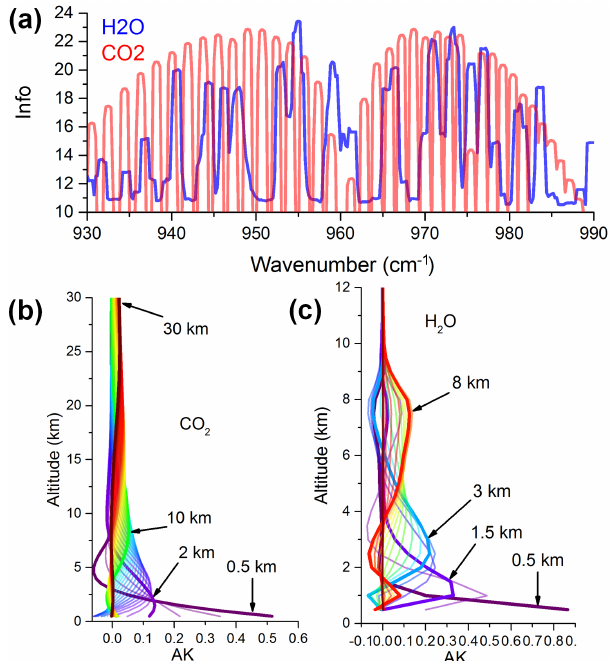
Figure 1. (a) Observing System Simulator retrieved Shannon infor- mation content for CO 2 and H 2 O for a narrow spectral window of 1cm − 1 , successively slid by 0.2cm − 1 over the full spectral range; (b) CO 2 and (c) H 2 O high-resolution averaging kernels computed for the finally selected narrow spectral window. The four thick lines pointed at by arrows correspond to the state vector heights used in the instrument performance simulation (Fig.